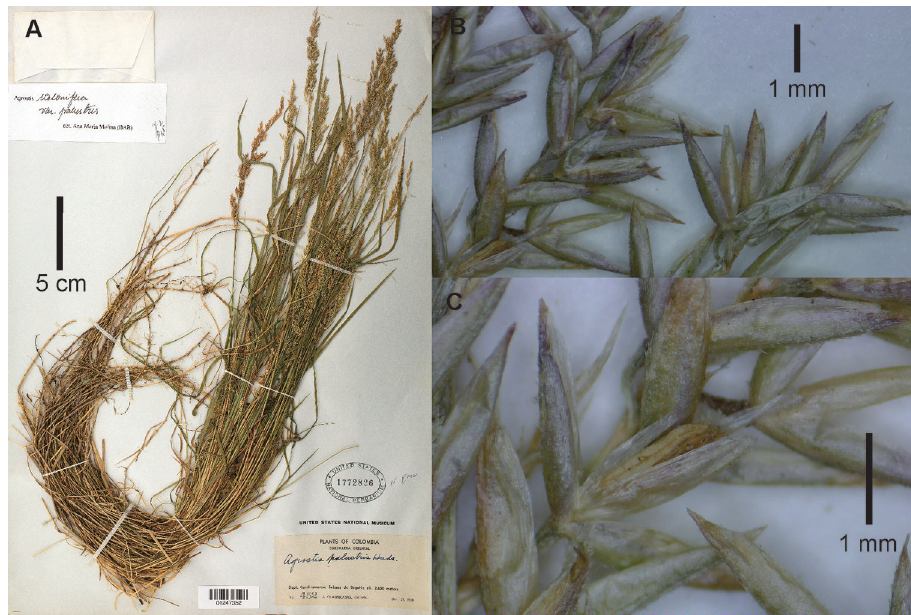
Figure 9. Agrostis stolonifera A whole plant B inflorescence, close-up C spikelet, close-up, lateral view. Image A Cuatrecasas 452 (US1772826) B García-Barriga 6 (US2115003).